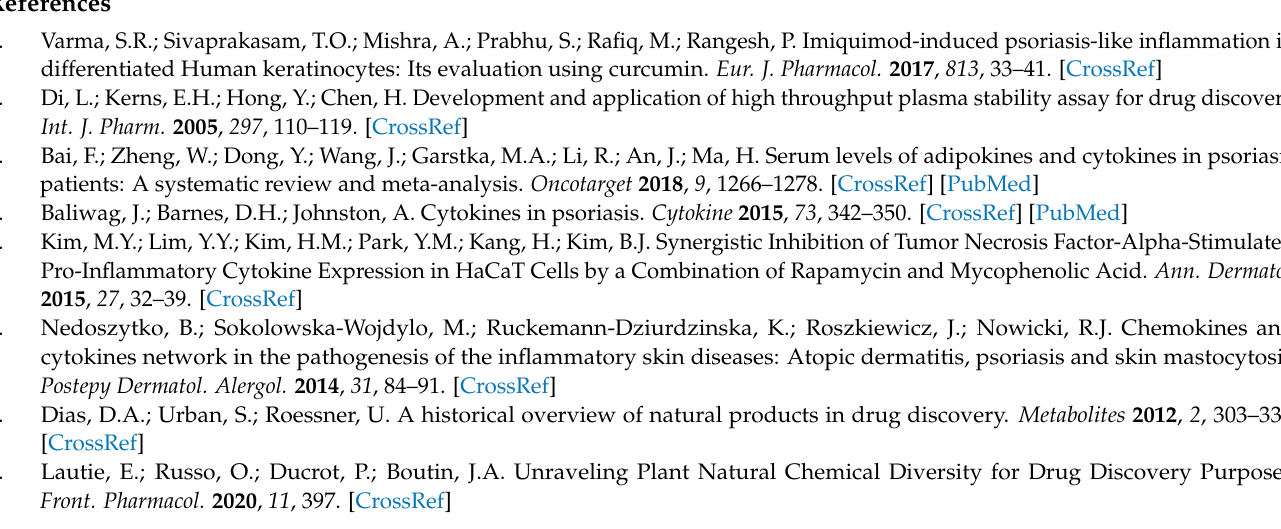
Figure S2: 1 H-NMR spectrum of MPA, CUR, and MPA-CUR conjugate, Figure S3: 13 C-NMR spectrum of MPA, CUR, and MPA-CUR conjugate, Figure S4. MS spectrum of